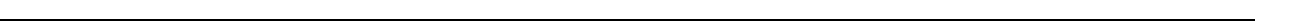
Fig. 5 Centriole over-elongation drives centriole ampli fi cation in cancer cells via ectopic procentriole formation and centriole fragmentation. a Centriole elongation and ampli fi cation are not independent. Higher proportion of overly long centrioles (>500 nm) in cells with centriole ampli fi cation (CA), ( p < 0.0001, Pearson ’ s Chi-squared test), compared with the expected proportions under the null hypothesis of independence. The expected and observed percentages of overly long centrioles in cells with no CA and CA are shown, together with a detailed view above, given the low frequency of overly long centrioles. b Induced centriole elongation triggers centriole ampli fi cation in cancer cell lines. CPAP was transiently overexpressed for 96 h in two cell lines from the NCI-60 panel, T47D and SF268, which do not normally display centriole over-elongation. Cells were stained with DAPI (blue), alpha-tubulin (a marker of MTs) and centrin (used as a readout for centriole number) antibodies (Scale bar 5 µ m). 3 independent experiments performed (depicted with squares, triangles and circles). 80 – 140 cells were counted per condition and per experiment. The bars represent the means ± s.d. *Represents a p < 0.05 (one-tailed unpaired t test with Welch ’ s correction). c Centriole fragmentation and ectopic centriole formation in cancer cells with overly long centrioles. Examples of structured Illumination Microscopy (SIM) and TEM pictures showing normal-length centrioles in the control cell line (upper panel), overly long centrioles with defective structures (middle panel), centriolar fragments (lower panel, inset 2 for SIM and insets of Ai, ii, iii for TEM) and ectopic procentrioles along the overly long centrioles (lower panel, labelled by asterisks in inset 3 for SIM and Biii and iv for TEM) in the MDA-MB-435 cell line. For SIM, cells were stained with DAPI (blue), acetylated tubulin (green) and STIL (red) antibodies, and were subjected to a 2 h cold treatment, prior to fi xation, to depolymerise the cytoplasmic MTs. For TEM, each picture represents an individual cell except for Ai, ii, iii and Bi, ii, iii and iv, where the pictures are serial sections of the same cell. Scale bar: 5 µ m (SIM) or 500 nm (TEM). Insets: 1 µ m (SIM) or 250nm